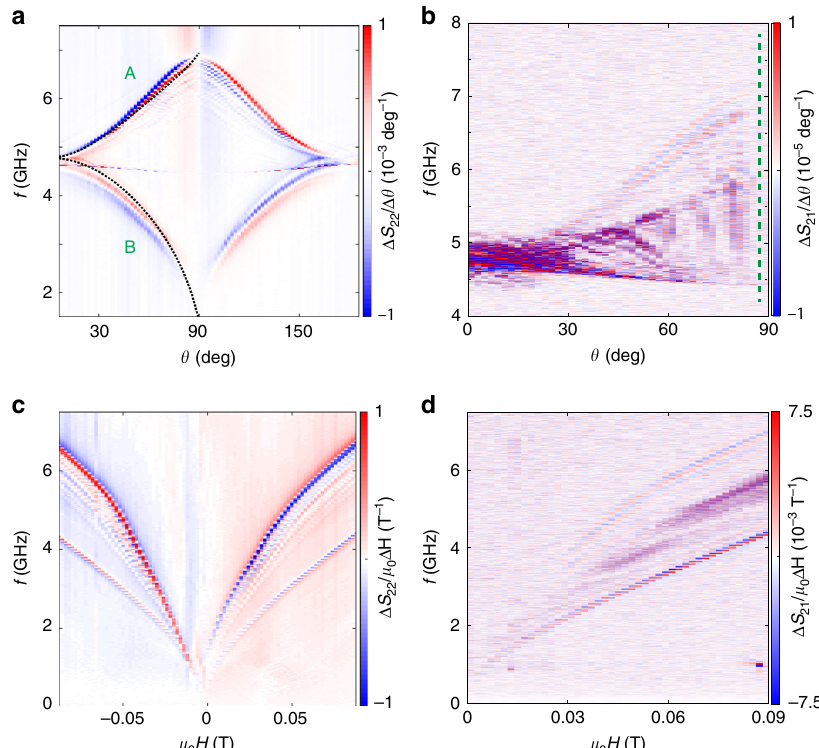
Fig. 2 Spectra of magnons emitted by mCPWs for fi elds applied under different angles θ . a Re fl ection and b transmission spectra taken for a fi eld of 0.09 T, where θ was varied in a step-wise manner. The data were obtained on thin YIG with mCPWs consisting of Fe(155 nm) ∣ Ti(5 nm) ∣ Au(120 nm) (sample 1). Black dotted lines in a are resonance frequencies calculated by considering simulated effective fi elds B eff in Kittel's formula 35 . They re fl ect B eff taken at the central positions in regions R G (top curve A) and R L (bottom curve B). The dashed vertical line in b indicates the angle at which the top line spectrum of Fig. 1b is extracted. c Re fl ection and d transmission spectra of sample 1 as a function of fi eld applied at θ = 90°. The color scales are de fi ned in the legends. The contrast was optimized to highlight the broadband magnon excitation. For data sets in c and d , the fi eld was reduced from 0.09 T to − 0.09 T.